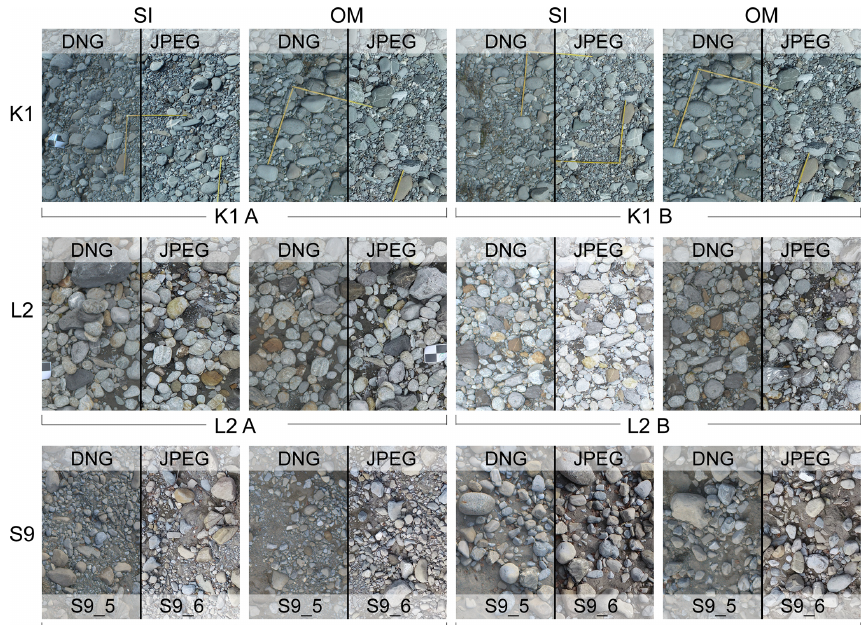
Figure 4. UAV imagery results illustrated by a selected range of images, for both image acquisition formats (JPEG and DNG) that we used for grain size estimation. The photos showcase survey-specific image conditions, e.g., shadows, exposure, saturation, and contrast, as well as site-specific variations, e.g., grain shape, color, or sand content. Please note that all these images, not only orthophoto mosaics (OM), are results that were achieved after photogrammetric processing, i.e., single images (SI) are undistorted with a camera model. All images in this figure were extracted from SfM models, which include GCPs and oblique camera angles in the bundle adjustment. Furthermore, these images only show parts of the corresponding images that were used for grain size estimation. For location reference, see Fig. 1.